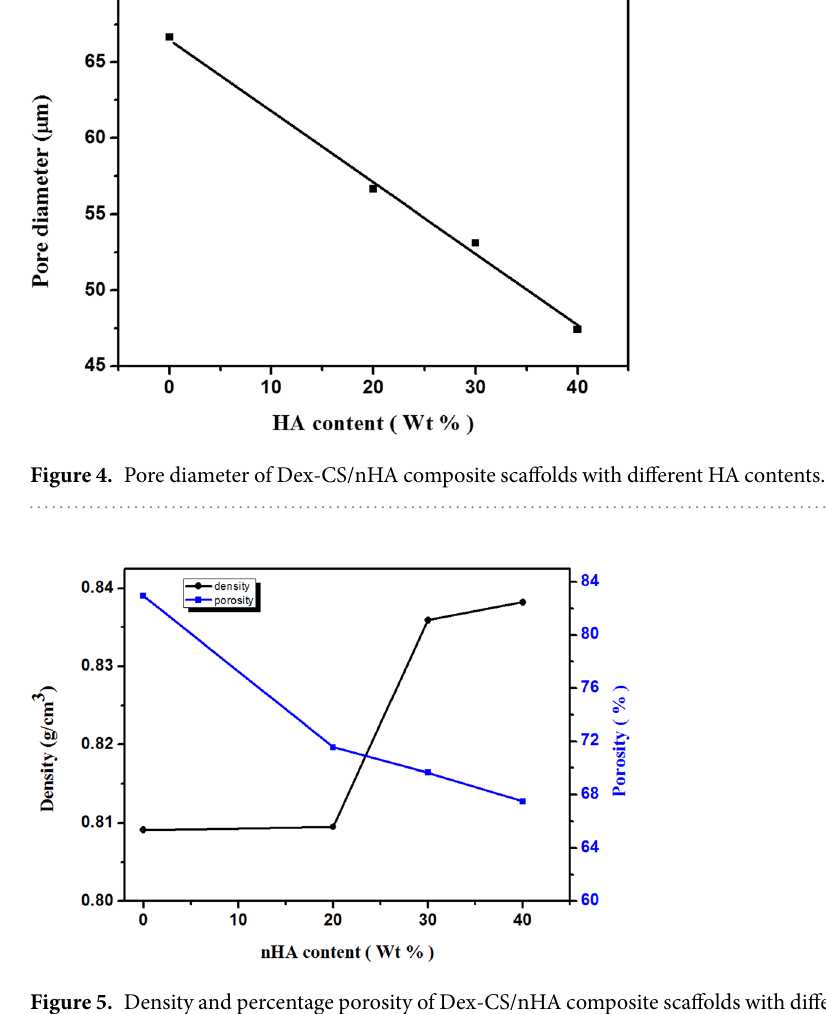
Figure 5. Density and percentage porosity of Dex-CS/nHA composite scaffolds with different HA contents.